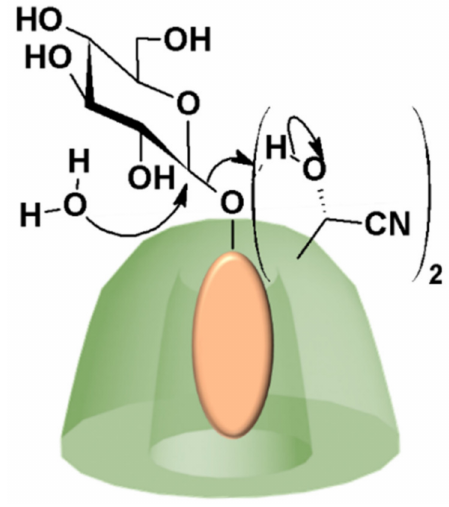
Figure 8. A “chemzyme”, based on cyanohydrin β -CD that mimics the mode of action of a